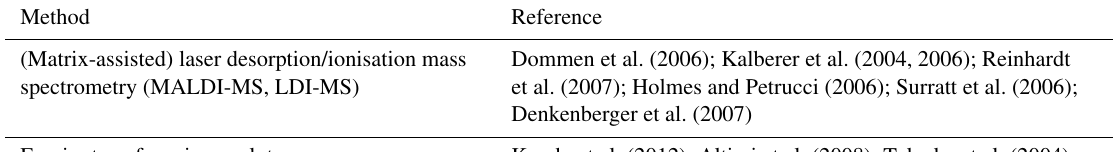
Table 1. Overview of methods for structure elucidation of oligomeric compounds (after Hallquist et al., 2009).